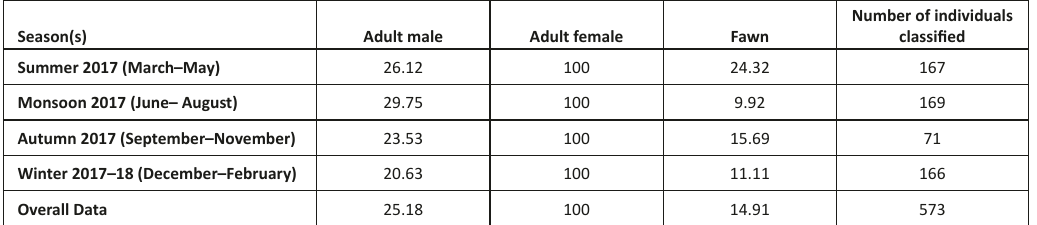
Table 2. Sex ratio of Blackbuck in Lalpur Jheel, Dobhi Village of district Hisar, Haryana (India) from March 2017 to February 2018. Season(s) Adult male Adult female Fawn